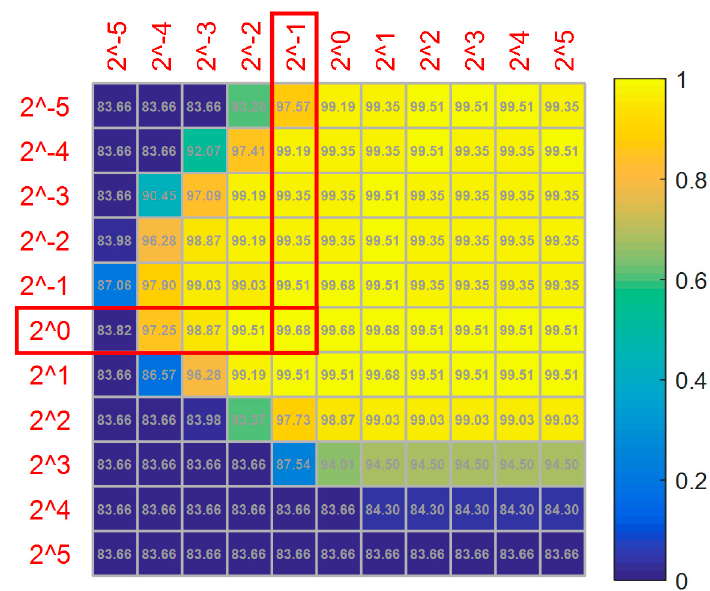
Figure 10. Results of the parameter optimization in the SVM classifier.